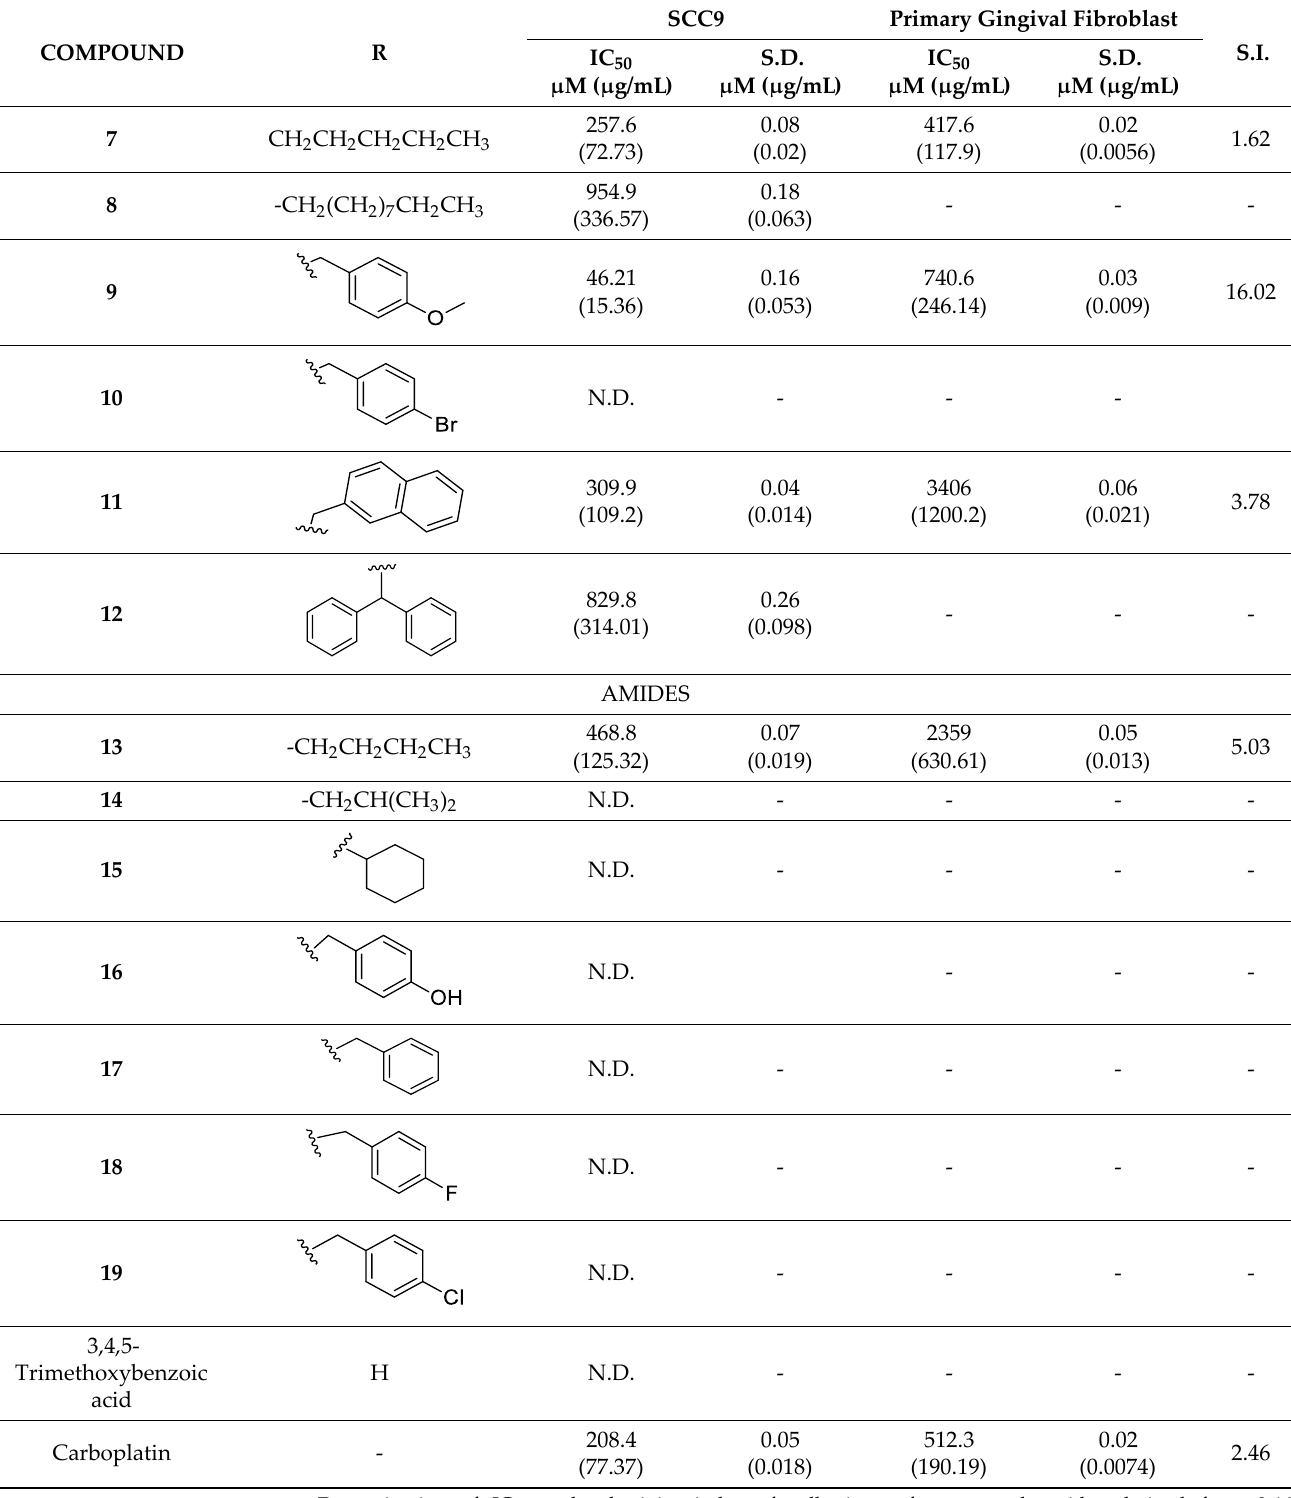
Determination of IC 50 and selectivity index of collections of esters and amides derived from 3,4,5- trimethoxybenzoic acid. SCC9 (OSCC cells) and normal human gingival fibroblasts were treated with the indicated compounds for 48 h, and cell viability was determined as indicated in materials and methods. Shown from left to right: compound nomenclature, SCC9 tumor or normal fibroblast,